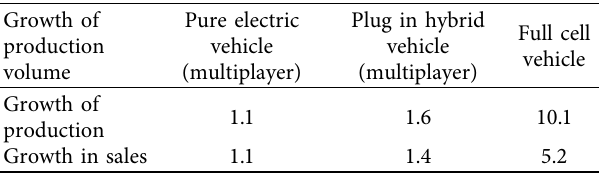
Table 3: The growth rate of production and sales of new energy vehicles.